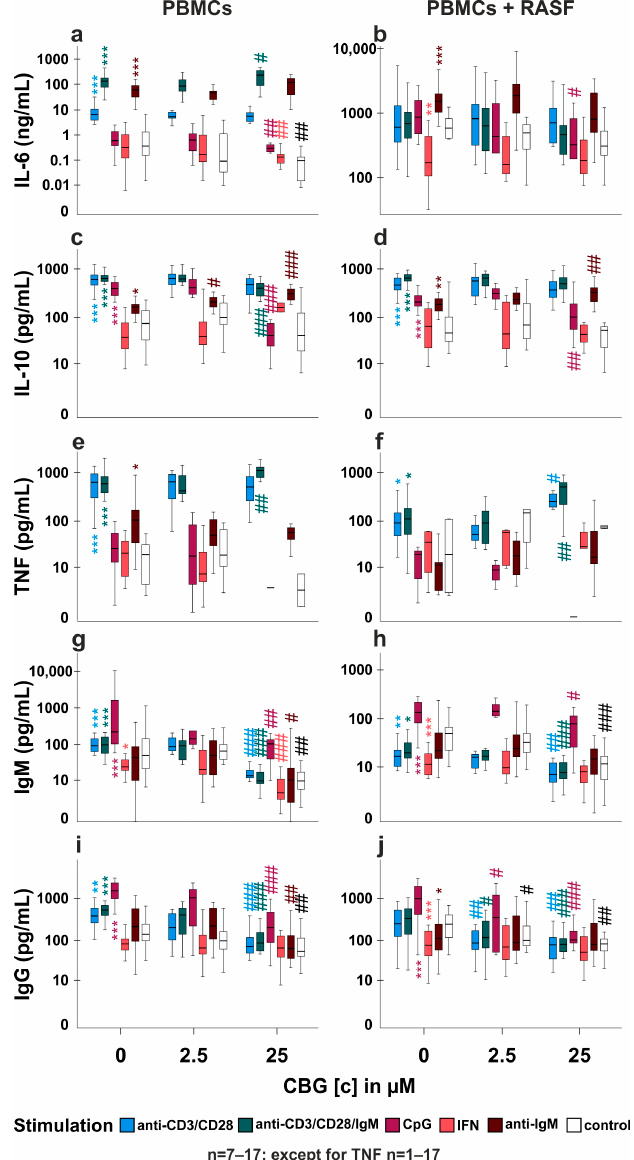
Figure 4. Influence of CBG on IL-6, IL-10, TNF, IgM and IgG production by PBMCs and PBMC/RASF co-cultures. ( a – j ) PBMCs alone ( a , c , g , e , i ) or PBMC/RASF co-cultures ( b , d , h , j ) were activated with anti CD3/CD28 (T cells), anti-CD3/CD28/IgM (T cells and B cells), CpG (B cells), anti-IgM (B cells) or IFN- γ (T cells) and concomitantly stimulated with CBG [2.5 µ M or 25 µ M] for 7 days in medium with 10% FBS. Thereafter, IL-6 ( a , b ), IL-10 ( c , d ), TNF ( e , f ), IgM ( g , h ) and IgG ( i , j ) were determined. Cytokine levels are presented on a logarithmic scale. *** p < 0.001, ** p < 0.01, * p < 0.05 for differences between treatment without CBG. Kruskal-Wallis test with Bonferroni post hoc test was used for comparisons. # p < 0.05, ## p < 0.01, ### p < 0.001 for comparisons of control versus CBG treatment